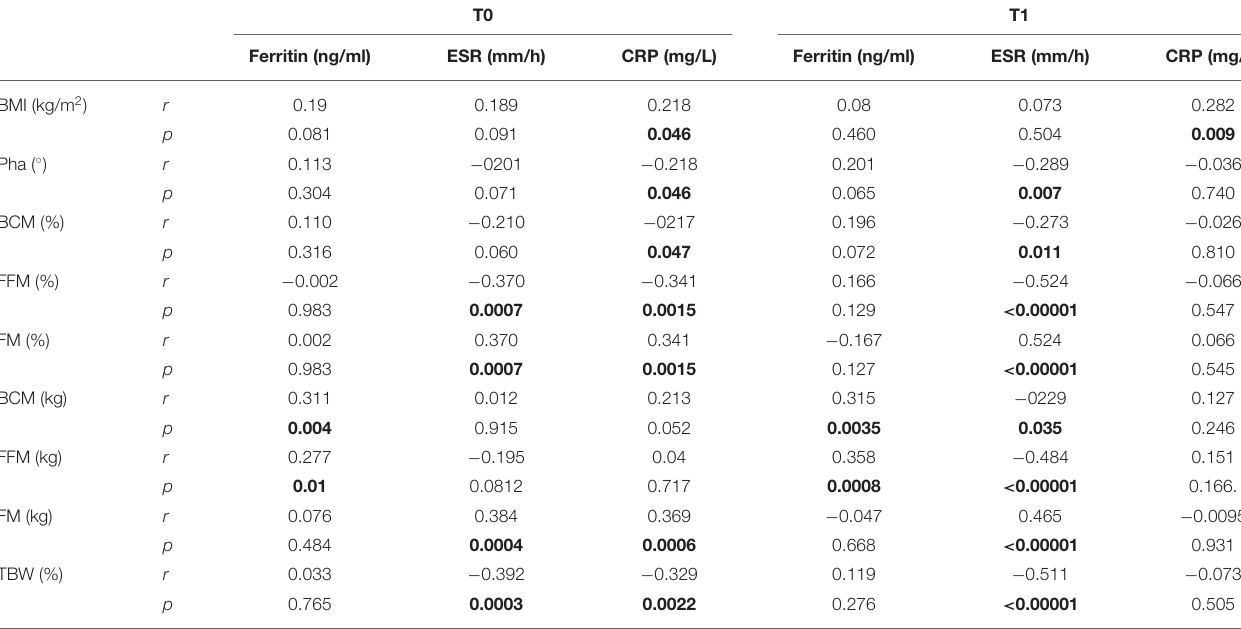
TABLE 4 | Correlations between serum ferritin, ESR, and CRP levels with body composition parameters in all the sample at baseline (T0) and after 6 months (T1).